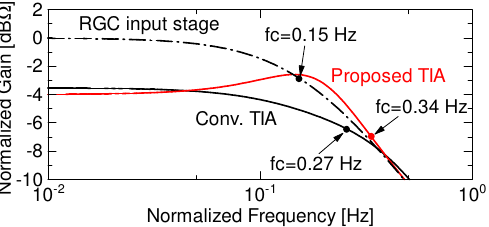
Figure 7. Compared normalized frequency and gain